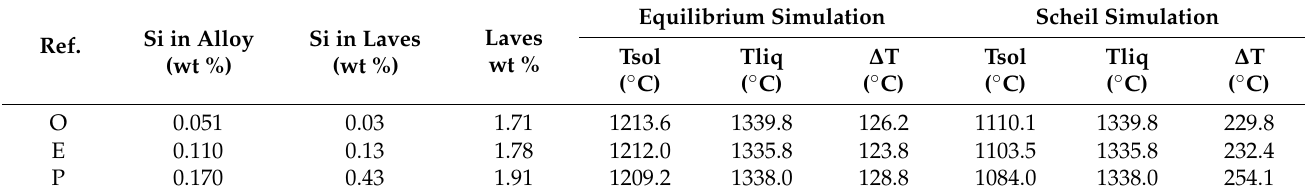
Table 10. Solidus and liquidus temperatures determined by equilibrium and Scheil simulation.